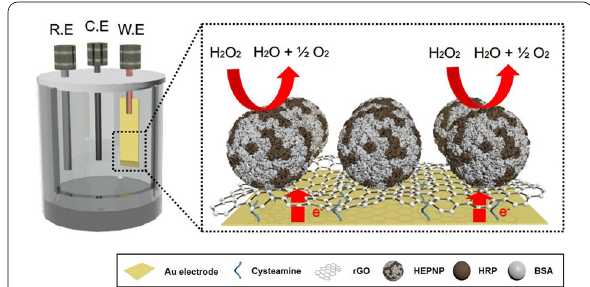
Fig. 1 Schematic diagram of H 2 O 2 electrochemical sensing principle of the biosensor using Horseradish peroxidase‑encapsulated protein nanoparticles (HEPNP) and reduced graphene oxide (rGO) modified Au electrode. R.E reference electrode, C.E counter electrode, and W.E working electrode)